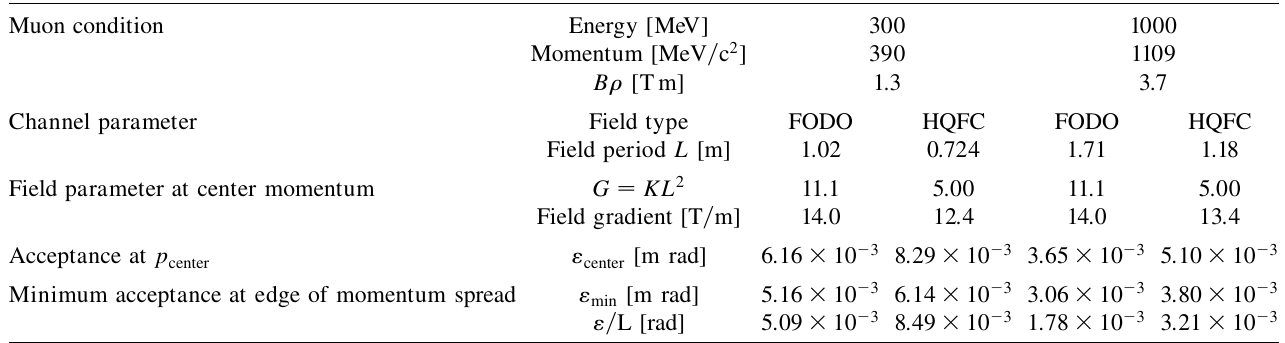
TABLE I. Example of HQFC and FODO.